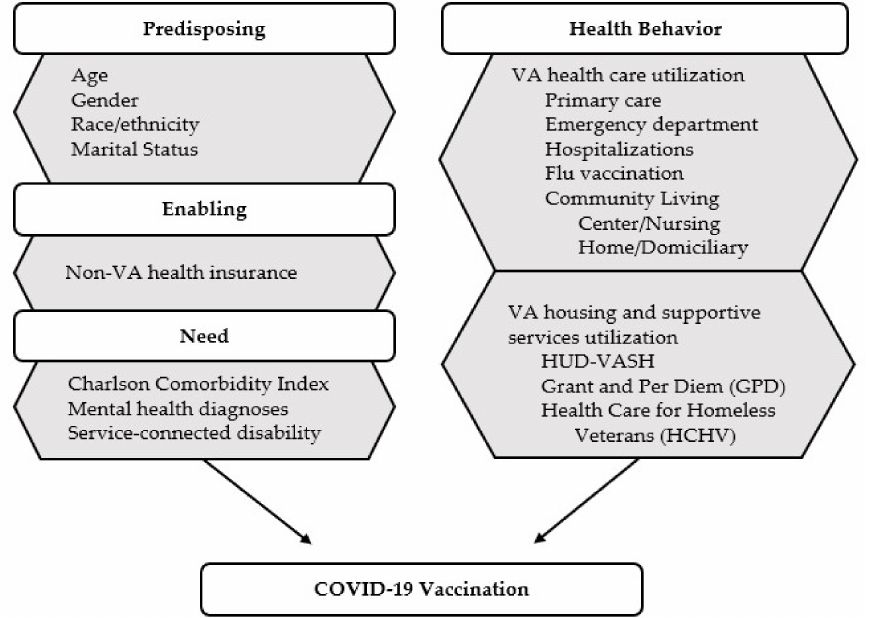
Figure 1. Predicting variables of COVID-19 vaccination among Veterans experiencing homelessness, guided by the Behavioral Model for Vulnerable